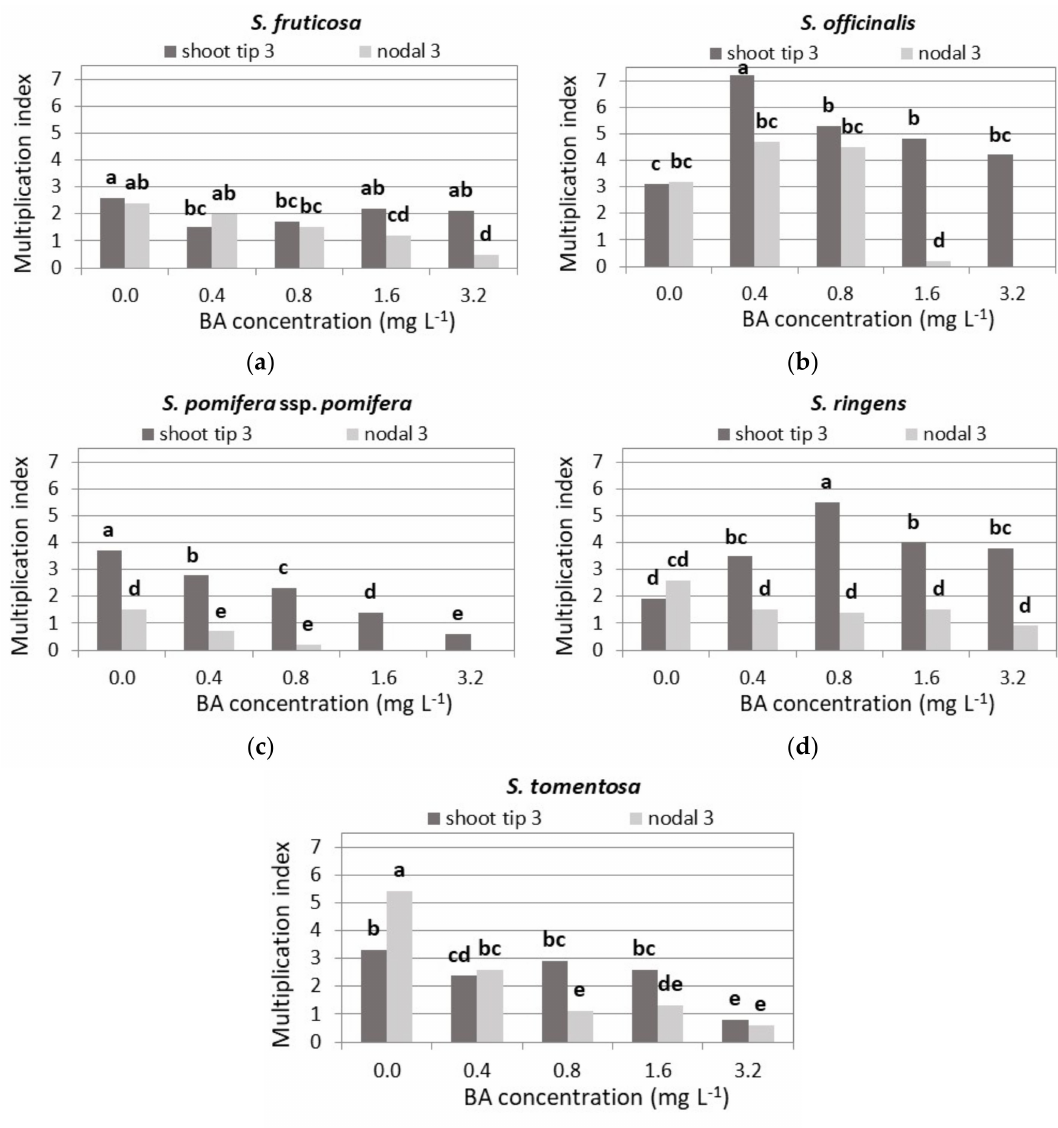
Figure 8. Effect of BA concentration on the shoot multiplication index of Salvia fruticosa ( a ), S. officinalis ( b ), S. pomifera spp. pomifera ( c ), S. ringens ( d ) and S. tomentosa ( e ), when shoot tip or single node (nodal) explants were cultured on MS medium, either hormone free or supplemented with 0.01 mg L − 1 NAA and BA concentration marked. Mean separation using Student’s t , p ≤ 0.05; means followed by the same letter are not significantly different at p ≤ 0.05, n = 30. Multiplication index = shoot-producing explants 1 (%) × mean shoot number 3 × mean node number 1 . Explants that formed both normal and hyperhydrated shoots. 3 Normal shoots per